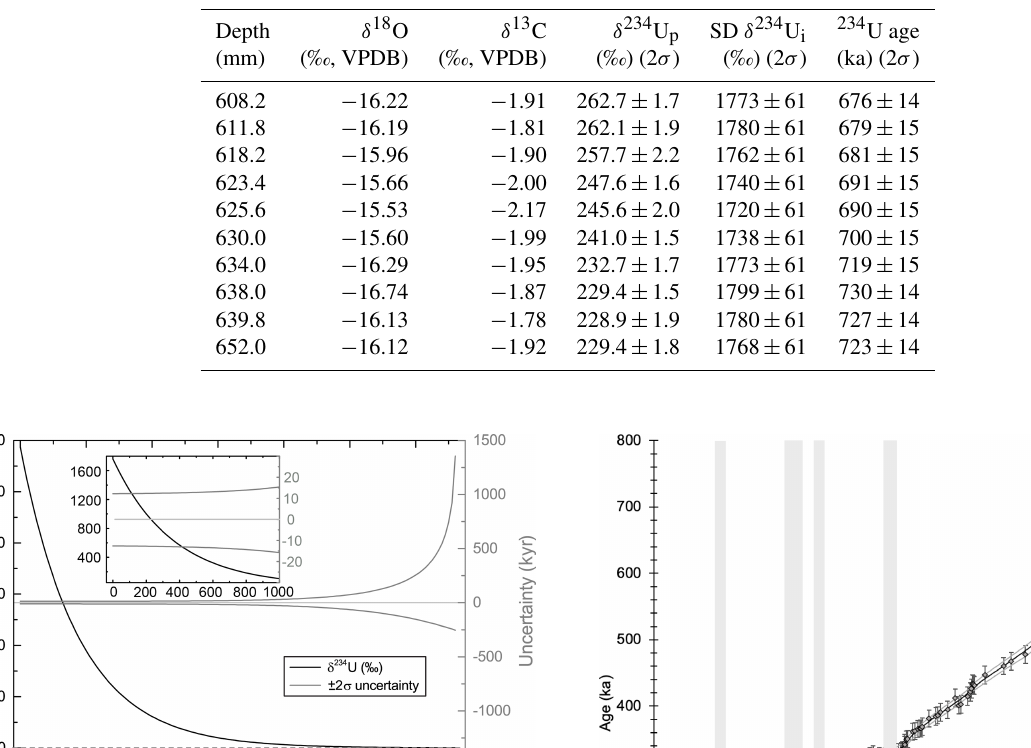
Table 5. SD δ 234 U i and calculated 234 U ages from calcite deposited prior to 600ka and the corresponding depth, δ 18 O, δ 13 C, and δ 234 U p values.